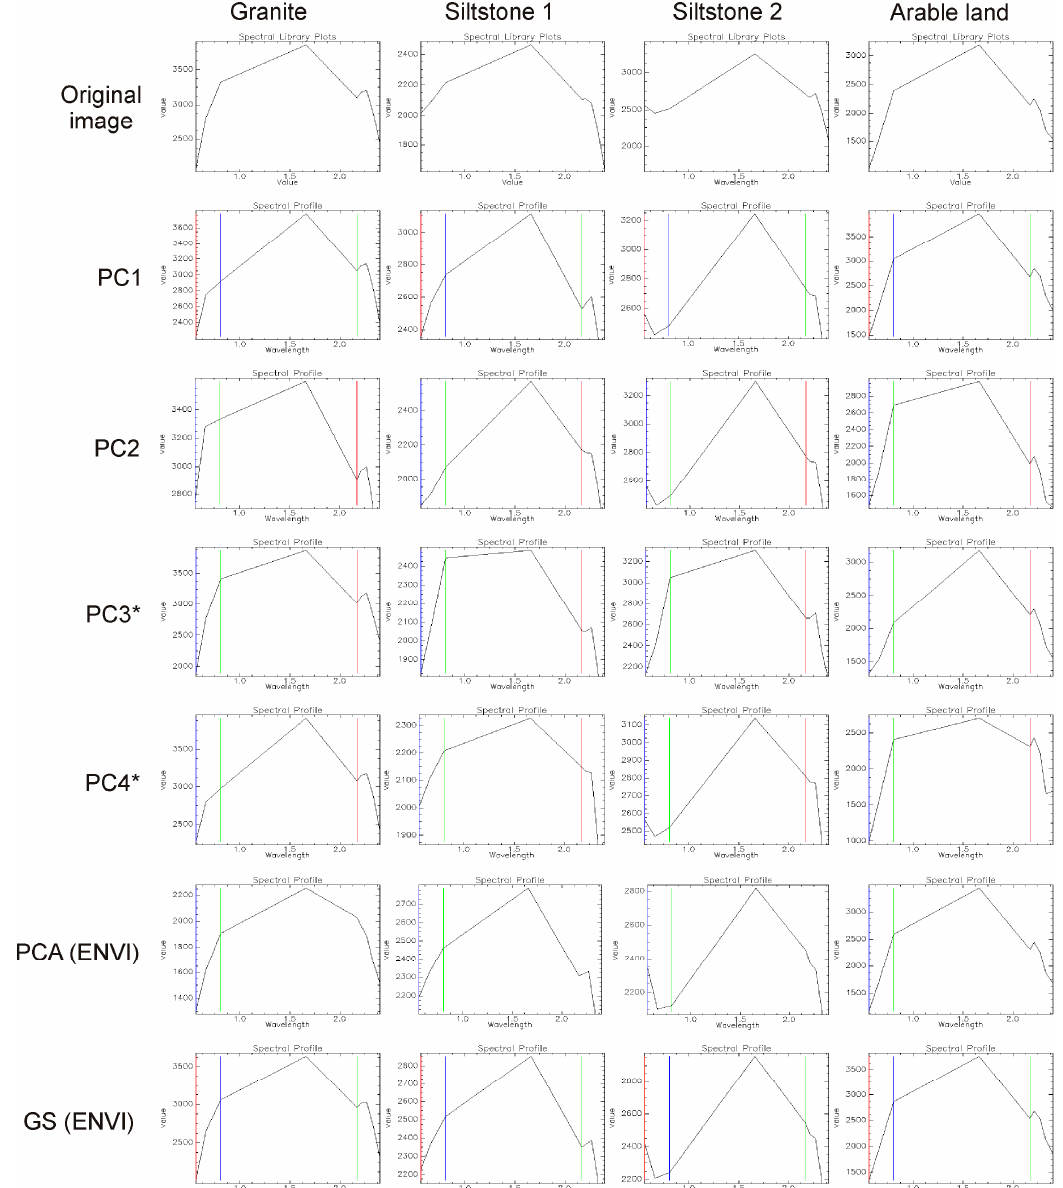
Figure 10. Comparison of the spectral curves of the test sites from each image at the 3.0-m spatial resolution of ASTER sharpened image. PC1–PC4 refer to sharpened images using the respective PCs for a PAN substitution, GS refers to the Gram–Schmidt sharpening algorithm. It was expected that the first two PCs have the potential to give good results when employing the PCA sharpening process, however PC3* and PC4* were used to compare the result and explain it in a wider context.